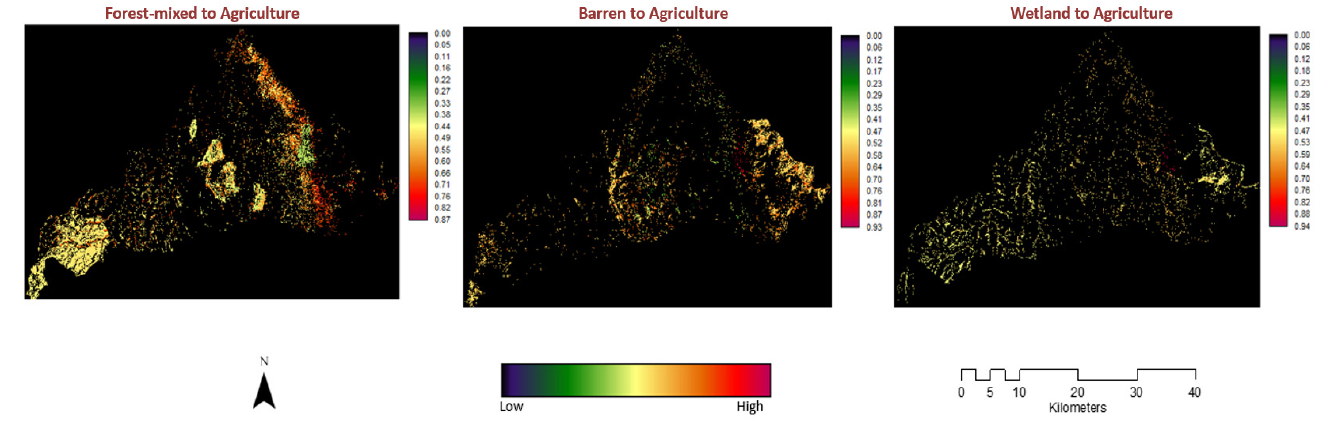
Figure 8. Land-Cover Transition Potentials (Probability): Dedza District.